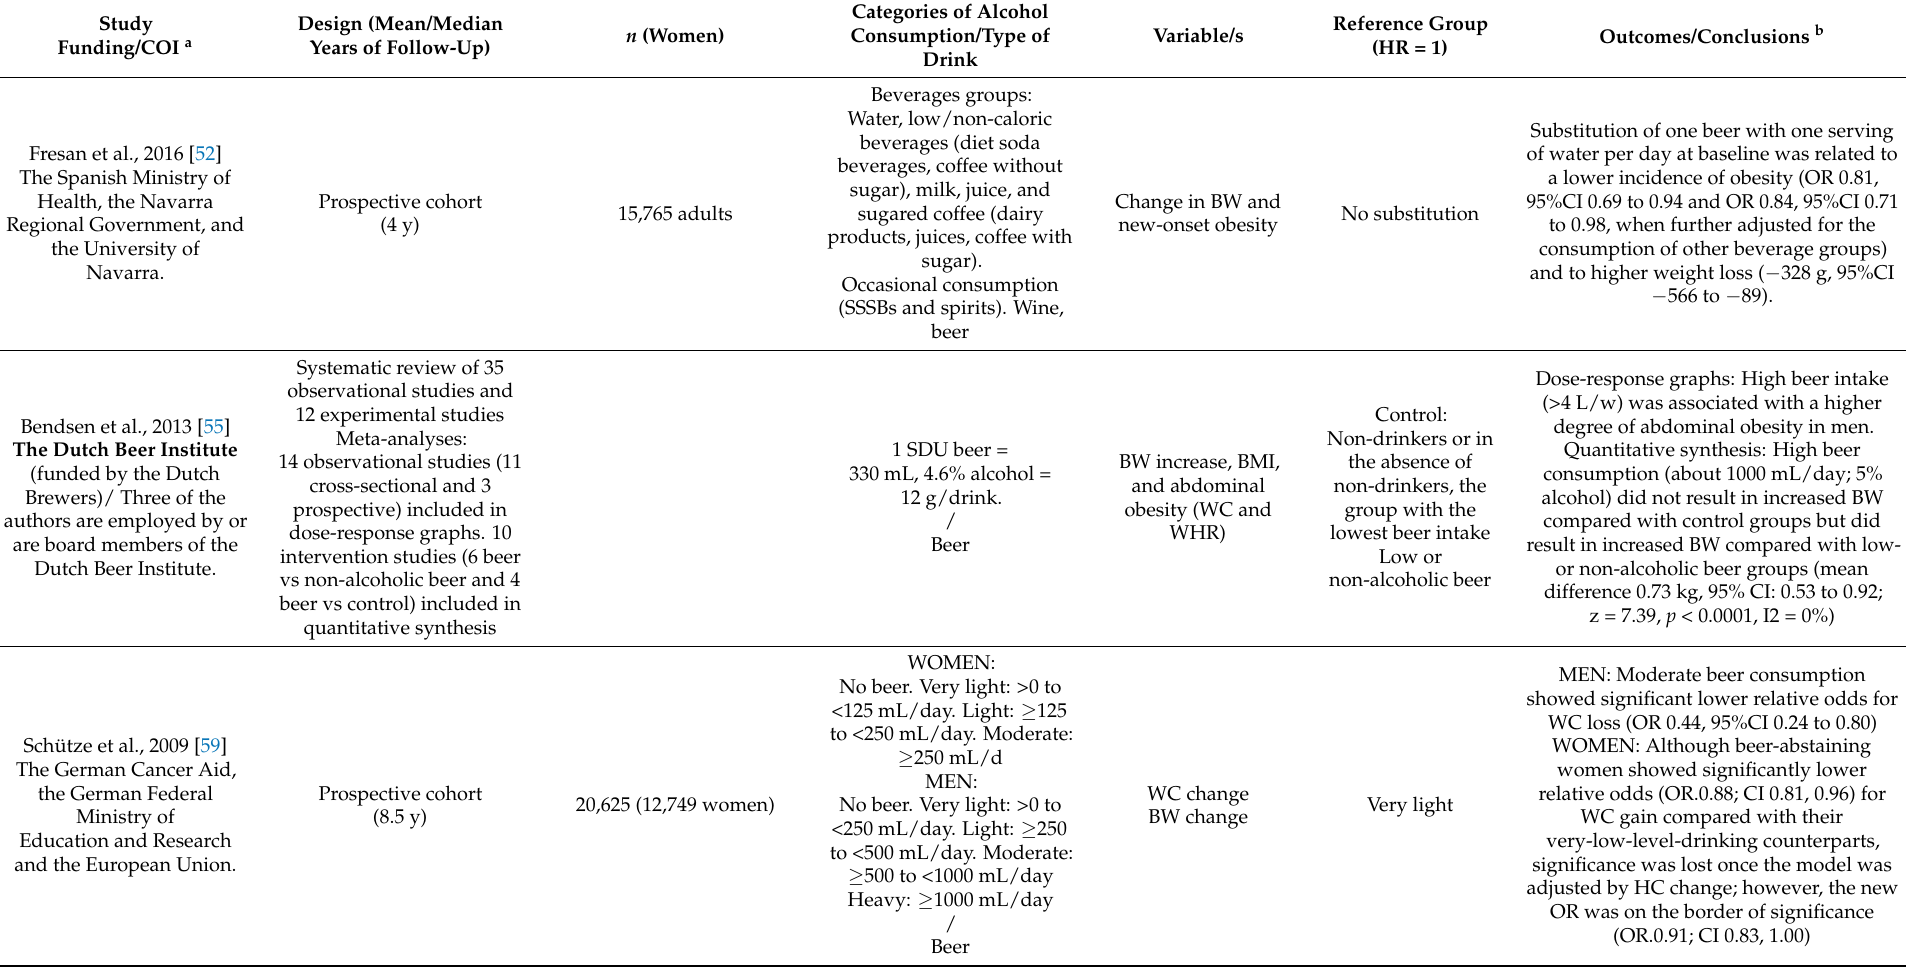
Table 6. Summary of main obesity, diabetes, and osteoporosis